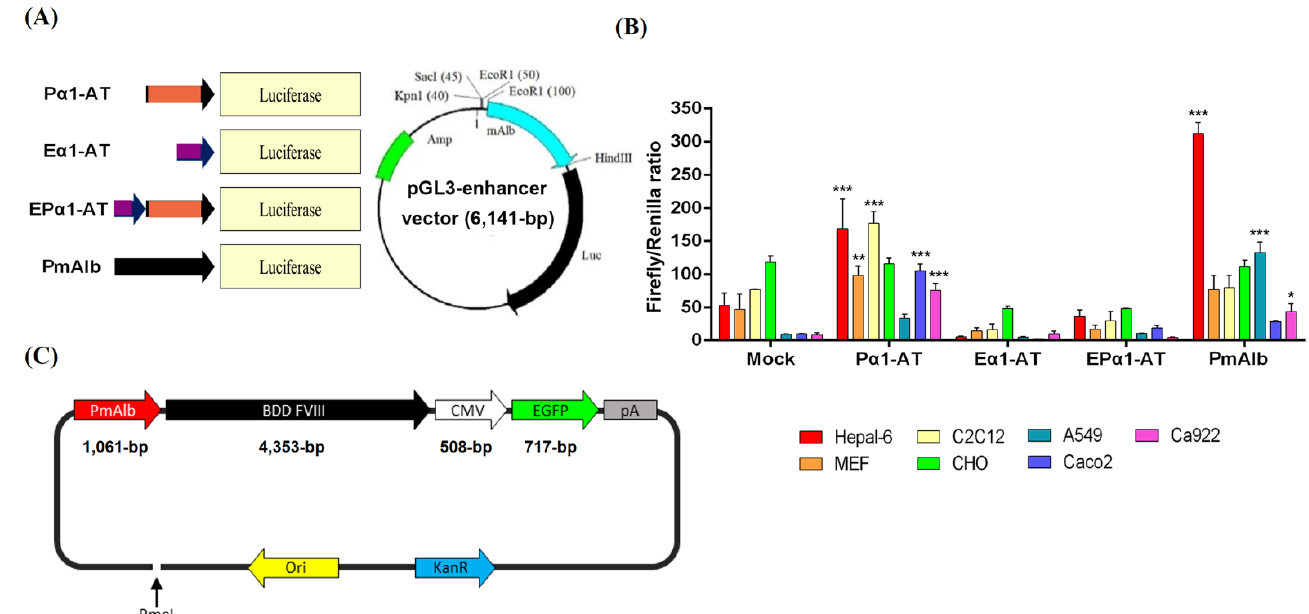
Figure 1. Liver-specific promoter construction and promoter activity measurement. ( A ) Four different liver-specific promoters, P α 1-AT, E α 1-AT, EP α 1-AT, and PmAlb, were generated and inserted into the pGL3-enhancer vector using the luciferase gene as a reporter for the promoter assay. ( B ) Detection of the firefly/Renilla ratio of each promoter in seven different cell lines (Hepa1-6, MEF, C2C12, CHO, A549, Caco-2, and Ca922) by dual-luciferase assays. Mock group: transfected cells as a background control. ( C ) PmAlb- BDD-FVIII- pCMV- EGFP plasmid map. Data are presented as the mean ± SD (n = 3), * p < 0.05 vs. the mock group, ** p < 0.01 vs. the mock group, *** p < 0.001 vs. the mock group.